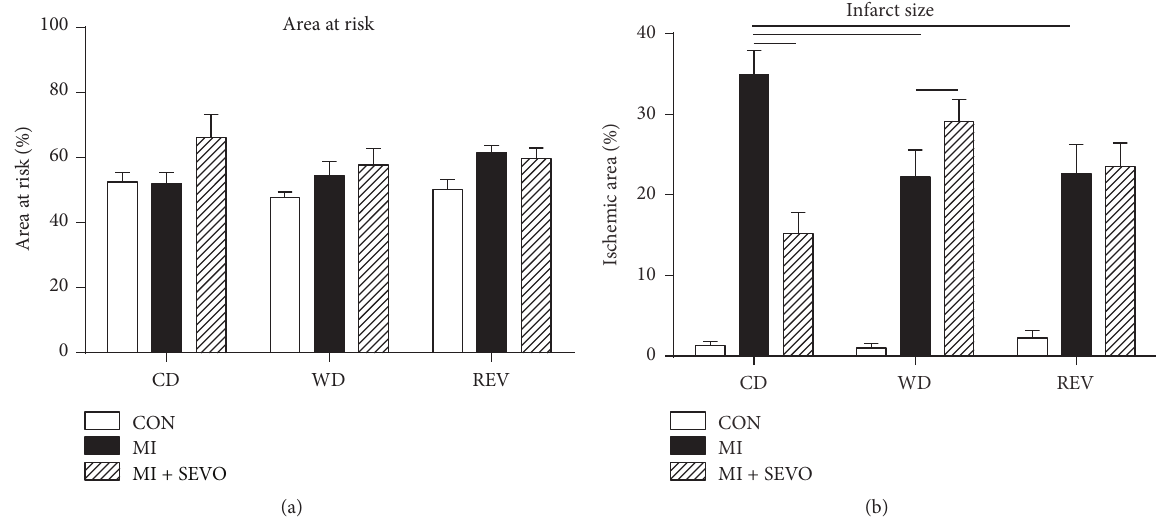
Figure 4: Myocardial ischemia and reperfusion injury. Area at risk (a) and infarct size (b) after sham (CON), myocardial infarction (MI), and myocardial infarction with sevoflurane (MI + SEVO) in rats after 8 weeks of control diet (CD), western diet (WD), or reversion diet (REV) feeding. Data are mean ± SD, 𝑛 = 8 –11, one-way or two-way ANOVA with Bonferroni post hoc analyses, — 𝑝 < 0.05. Table 3: Hemodynamics during myocardial ischemia and reperfusion after 8 weeks of diet intervention. Control diet Western diet Reversion CON MI MI + SEVO CON MI MI + SEVO CON MI + SEVO